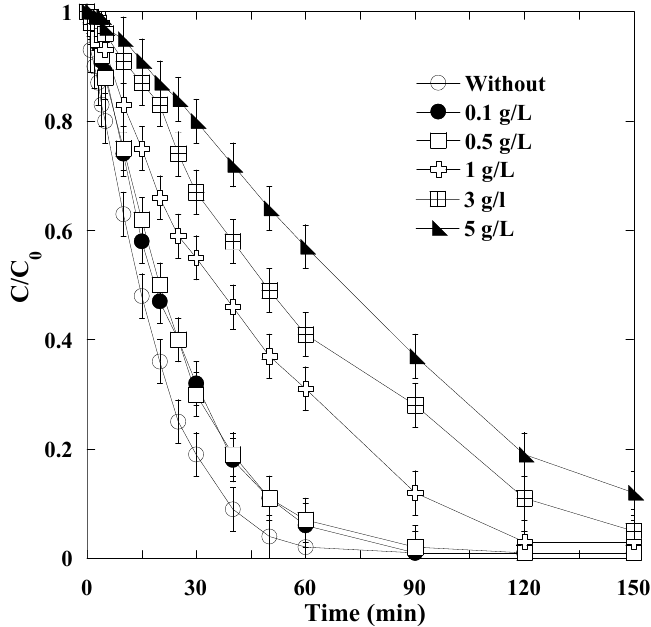
Figure 12. Sucrose’s effect AO10 degradation ([AO10] 0 = 50 mg/L, 20 ± 1 ◦ C, [IO 4 − ] = 3 mM, Figure 12. sucrose’s effect AO10 degradation ([AO10] 0 = 50 mg/L, 20 ± 1 °C, [IO 4- ] = 3 mM, irradiation irradiation intensity: 15 mW/cm 2 intensity: 15 mW/cm²).